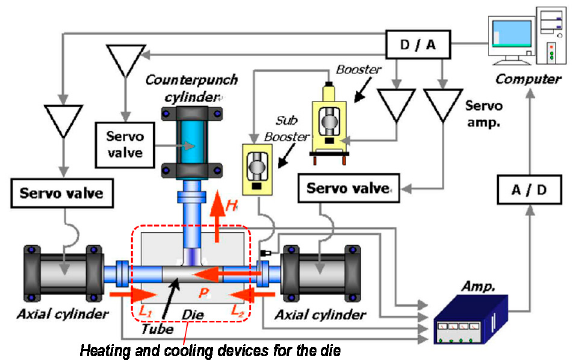
Figure 3. Configuration of a hydraulic circuit and its closed loop control system in WTHF.